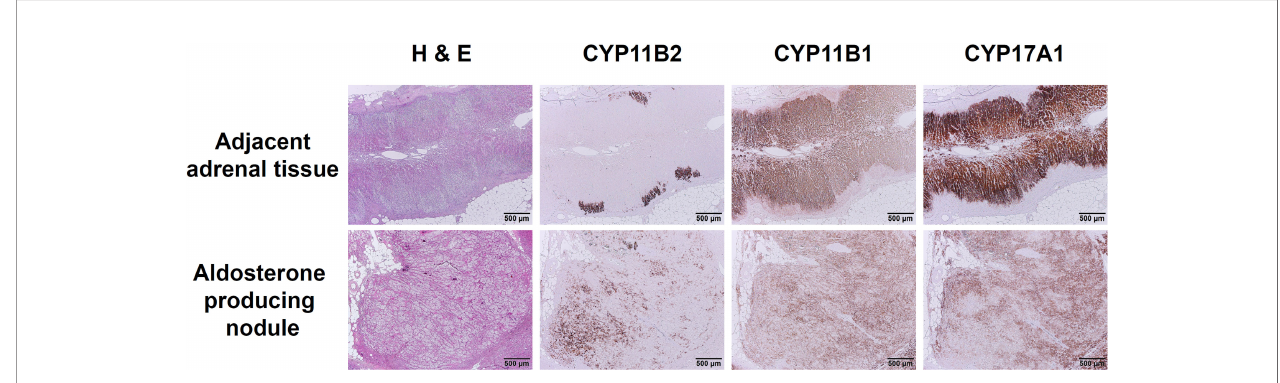
FIGURE 3 | Immunohistochemical staining of CYP11B2, CYP11B1, and CYP17A1 in aldosterone-producing nodule with CACNA1H p.V1937M variant. The immunoreactivity of CYP11B2 IHC staining was prominent in CACNA1H p.V1937M variant nodule compared to the adjacent adrenal tissue with discrete aldosterone-producing micronodules. Little immunoreactivity of CYP11B1 and scattered immunoreactivity of CYP17A1 appeared in CACNA1H p.V1937M mutated nodule. Scale bar, 500